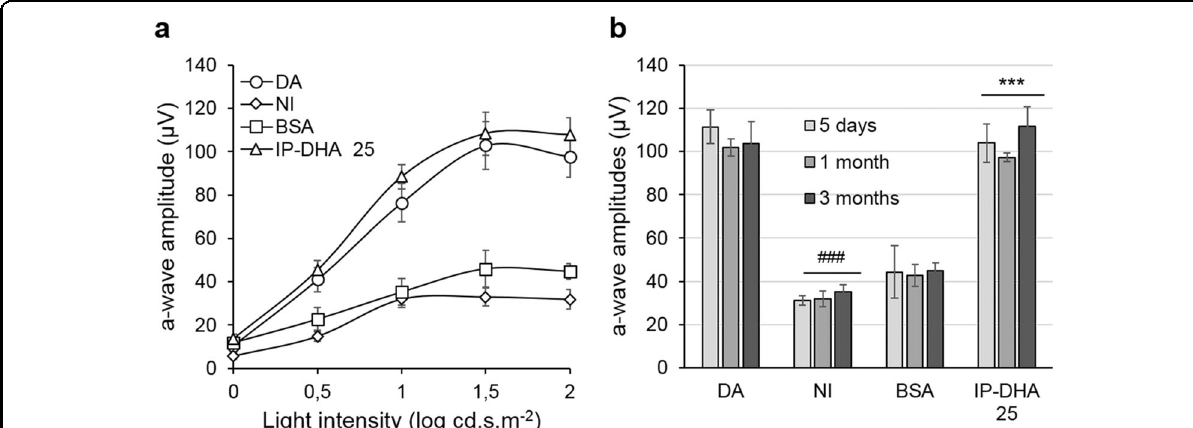
Fig. 5 Effect of IP-DHA on light-induced degeneration over time. a Full- fi eld ERG responses of Abca4 − / − mice 3 months after a single IP-DHA injection. ERG scotopic responses were recorded, and a-wave amplitudes were plotted as a function of light intensity. IP-DHA (25 mg/kg)-treated mice exposed to light showed an a-wave amplitude similar to that of DA control mice, whereas BSA-treated and untreated (NI) mice exposed to light did not recover amplitudes. The data are presented as the mean ± SEM from n = 5 – 6 mice. b a-wave amplitudes recorded at 2-log cd.s.m − 2 did not change in each treatment over the 3-month period. The data are presented as the mean ± SEM from n = 5 mice. One-way ANOVA with Bonferroni ’ s multiple comparison posttest: ### p < 0.001, NI vs. DA; *** p < 0.001, IP-DHA25 mg/kg vs. BSA; IP-DHA vs. DA, nonsigni fi